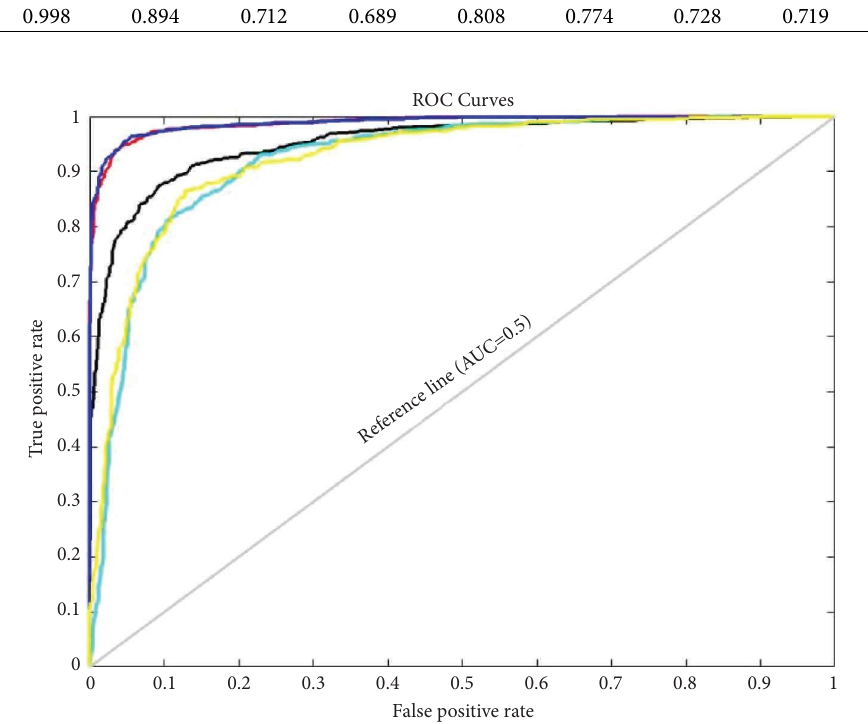
Figure 9: ROC curves and AUC values of all the